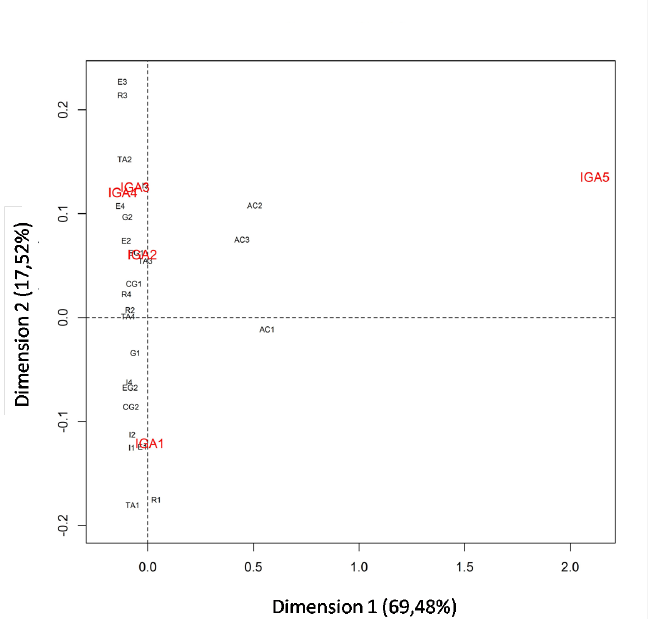
Correspondence Map of the items of question 1 regarding teachers’ perception about genetic and environmental influences on mental disorders, and the sample groups